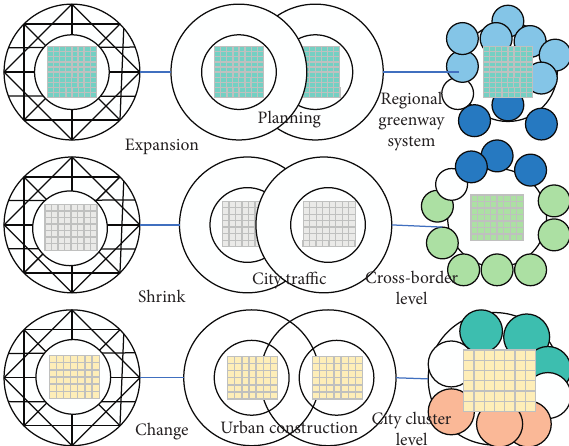
Figure 2: Graphic representation of planar plaque